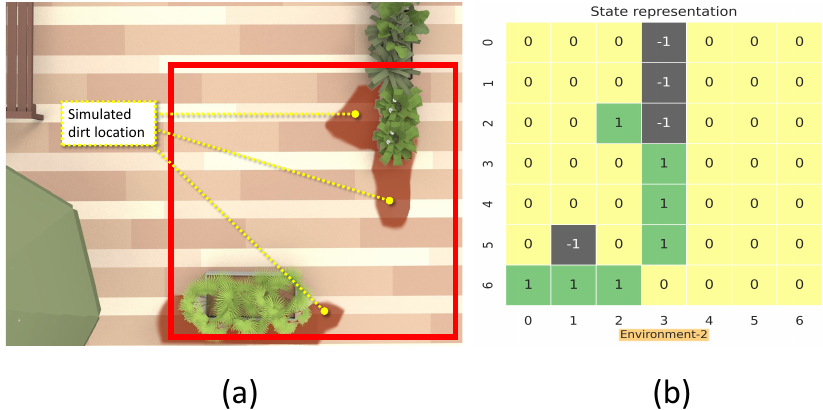
Figure 5. The simulation environment 2 ( a ), and 7 × 7 reduced environment representation ( b